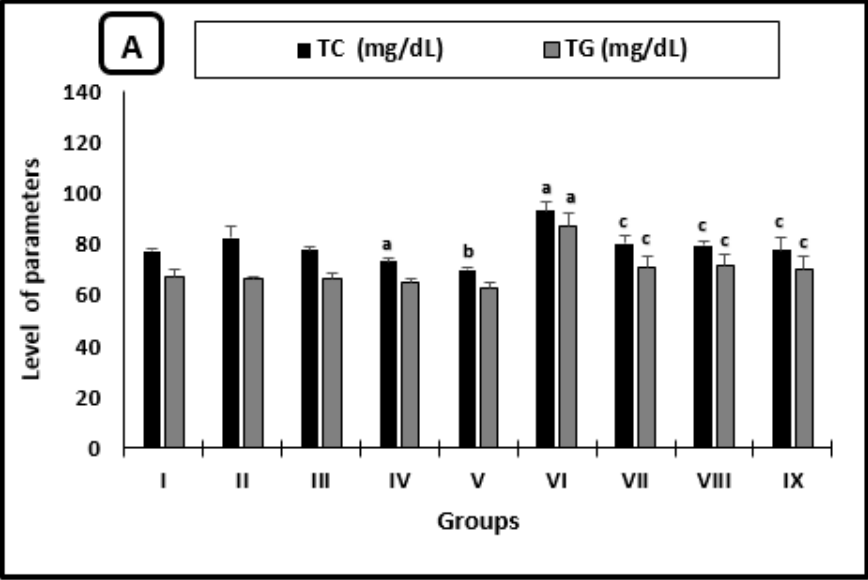
Table 6. Changes in platelets and their indices of mice after two weeks of the treatment.